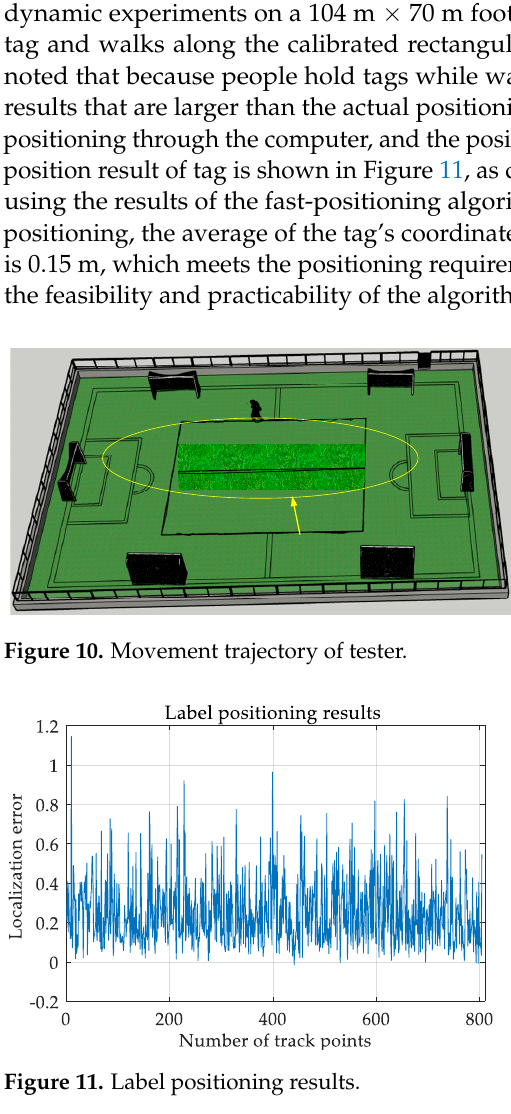
Table 3. Base stations coordinate error coefficient and root mean square error.